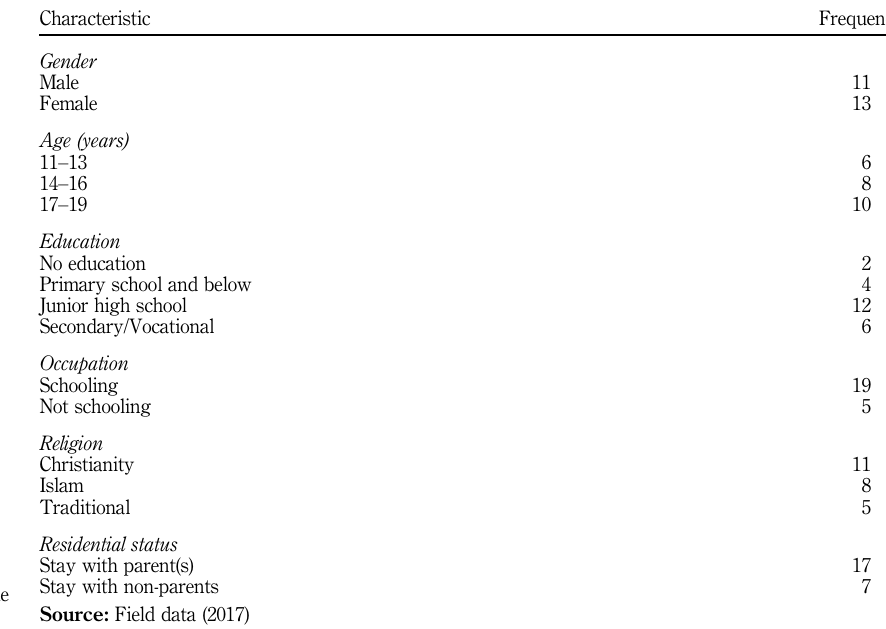
characteristics of the